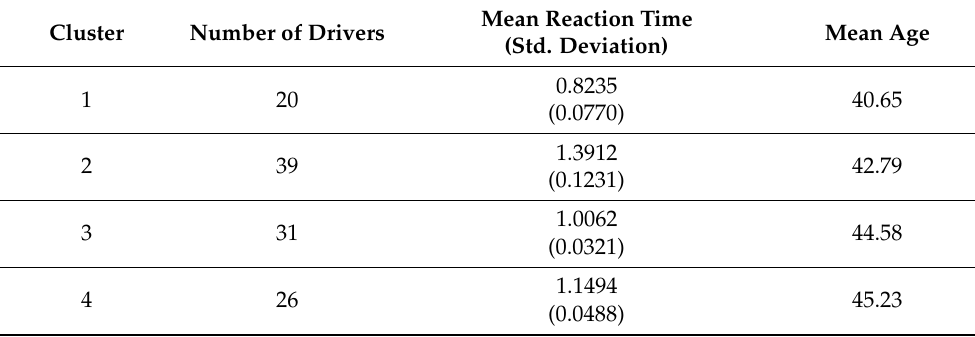
Table 5. Reaction times and ages of the drivers in the created clusters.